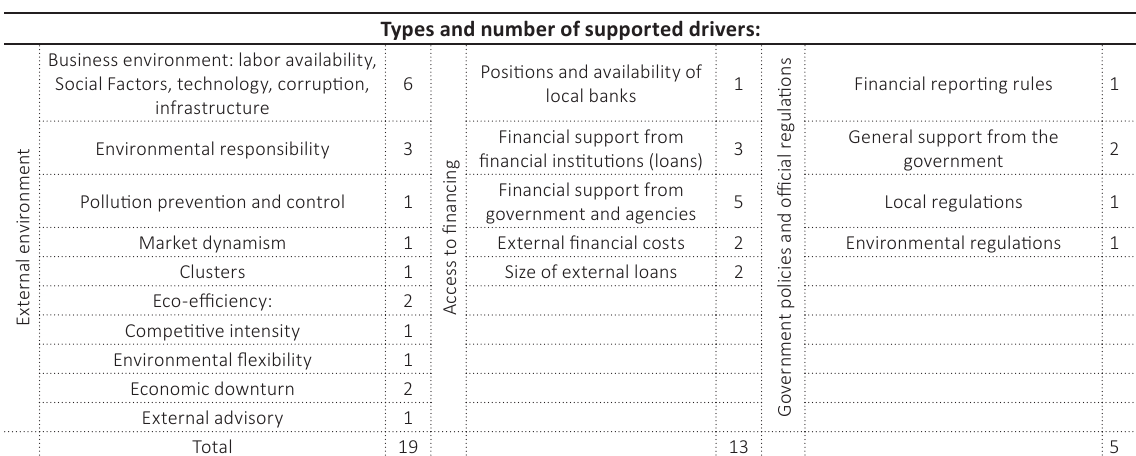
Table 3. External drivers of